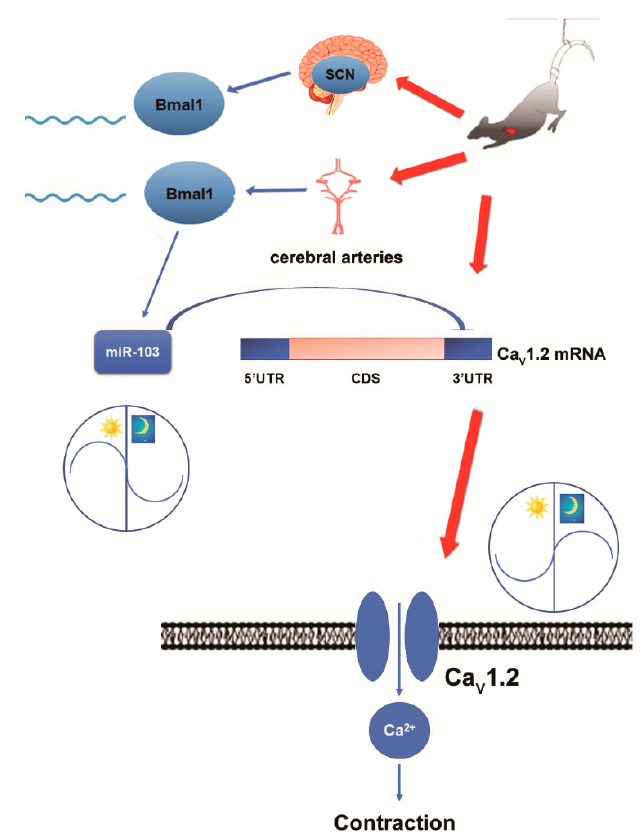
Figure 7. A schematic model of the circadian regulation of BMAL1/miR-103/Ca V 1.2 signal pathway and the disruption of simulated microgravity.